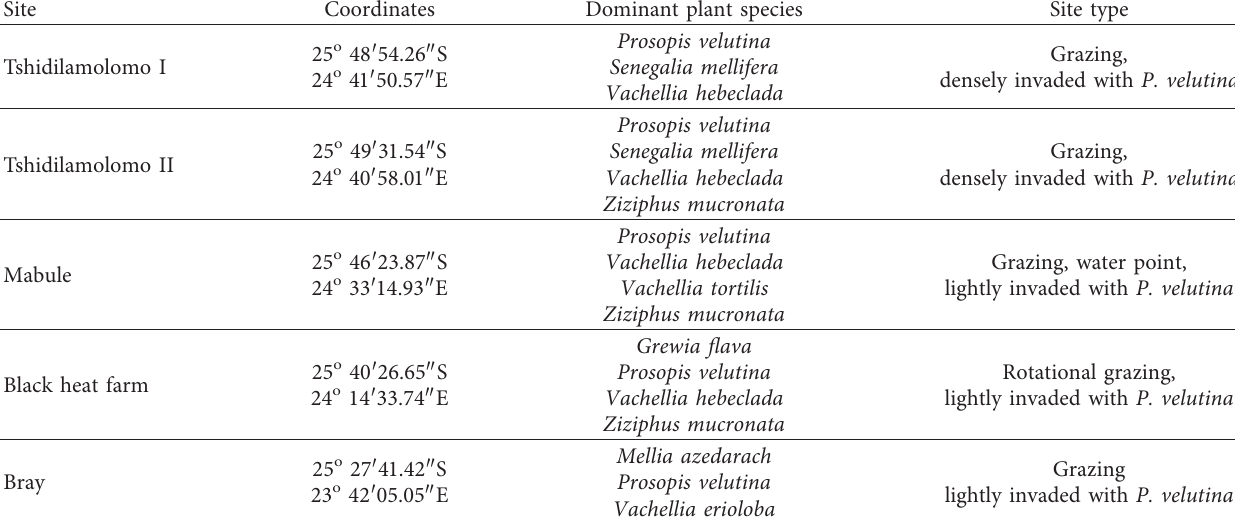
Table 1: Site locations and dominated plants species at five sites of Prosopis velutina